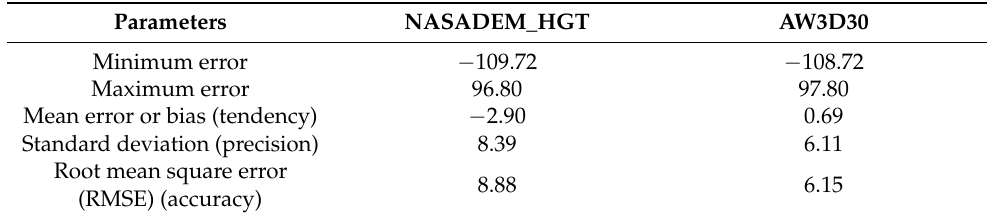
Table 9. Statistics of altitude